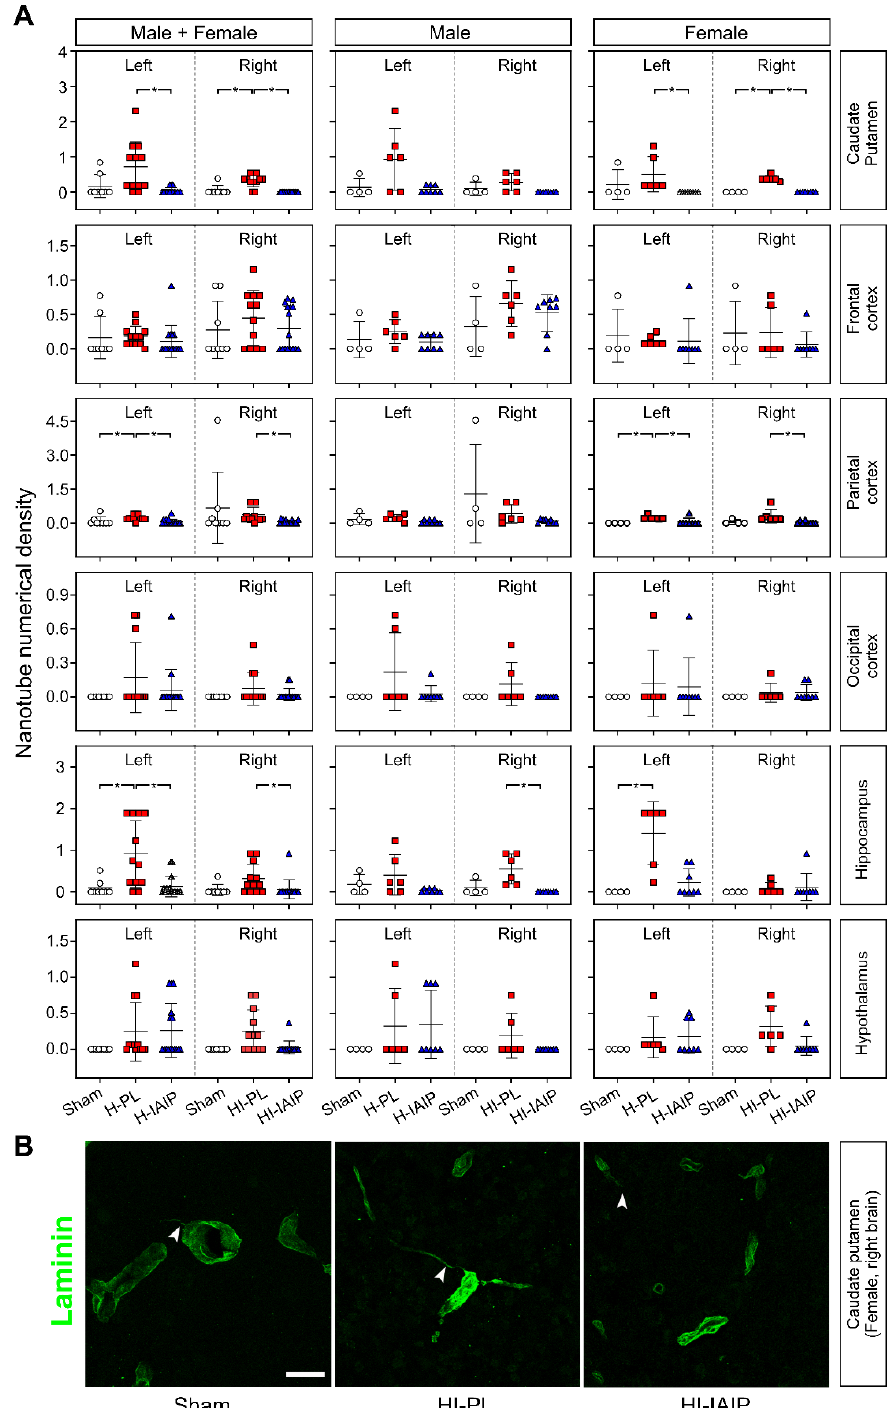
Figure 4. The effects of systemic treatment with IAIPs on TNT numerical density in neonatal rats exposed to systemic hypoxia (H - left) and hypoxia – ischemia (HI - right) injury. ( A ) Quantification of cumulative TNT linear density in the selected brain regions of total males + females and separately for the male and female left and right hemispheres. Data are mean ± SD. Male: sham = 4, H - PL/HI - PL = 6, H - IAIP/HI - IAIP = 8. Female: sham = 4, H - PL/HI - PL = 6, H - IAIP/HI - IAIP = 8. * p ≤ 0.05 for indicated comparisons. ( B ) Representative images of HI - right caudate – putamen, immunostained for laminin, showing the presence of TNTs connecting two microvessels (arrowhead, HI - PL) in neonatal female rats. In sham - operated and HI - IAIP - treated female rats, TNTs, although present (arrowhead), are rare. Scale bar: 25 µm.